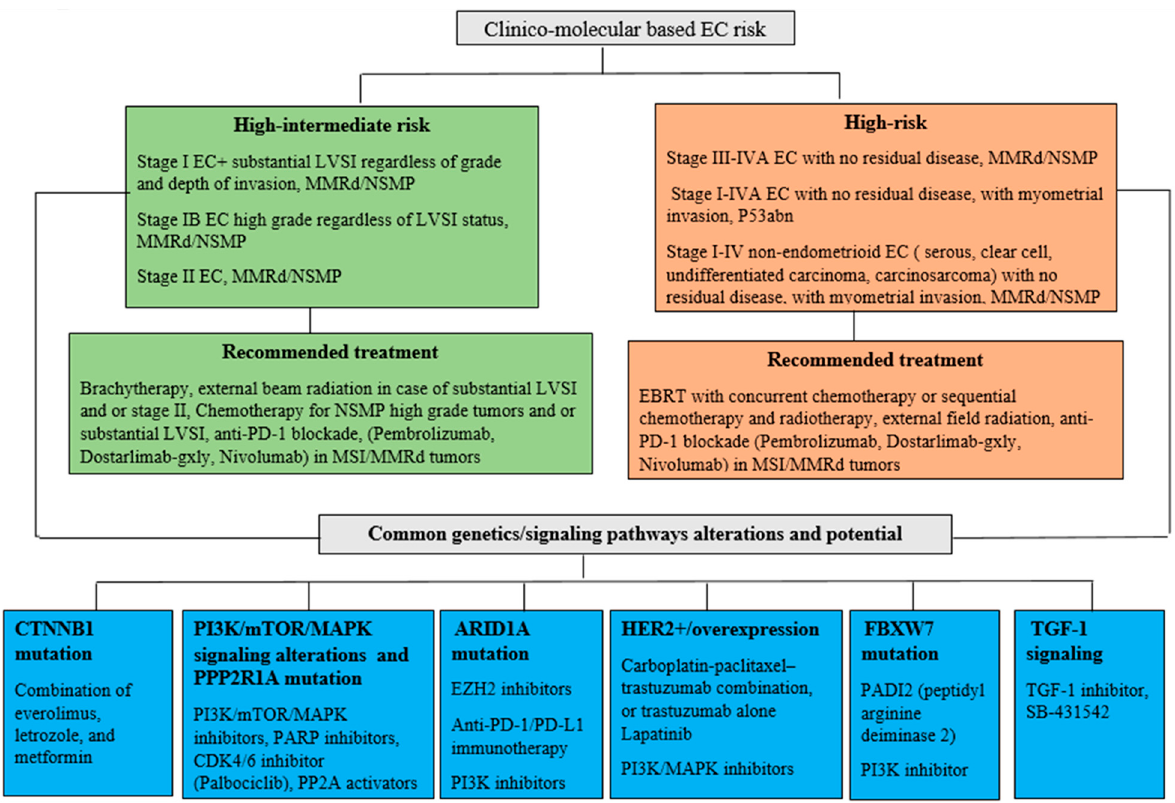
Figure 1. Molecular and genetic alterations in HR-EC with potential therapeutic targets and benefits. The classification of high-intermediate and high-risk EC based on the clinico-molecular risk stratification resulted in recommended treatment regimens in these categories. Anomalies in these tumors’ genetic and signaling pathways may also offer a novel treatment strategy and benefit based on specific alterations. Endometrial cancer (EC), lymphovascular space invasion (LVSI), mis- match repair deficiency (MMRd), non-specific molecular pattern (NSMP), catenin beta 1 (CTNNB1), mammalian target of rapamycin (mTOR), phosphoinositide 3-kinase (PI3K), microtubule associated protein kinase (MAPK), F-box and WD repeat domain containing protein 7 (FBXW7), protein phosphatase 2 scaffold subunit A alpha (PPP2R1A), human epidermal growth factor receptor 2 (HER2), AT-rich interaction domain 1A (ARID1A), poly adenosine diphosphate-ribose polymerase (PARP), enhancer of zeste homolog 2 (EZH2), transforming growth factor 1 (TGF-1), cyclin-dependent kinase 4/6 (CDK 4/6), and programmed cell death 1/ligand 1 (PD-1/PD-L1).